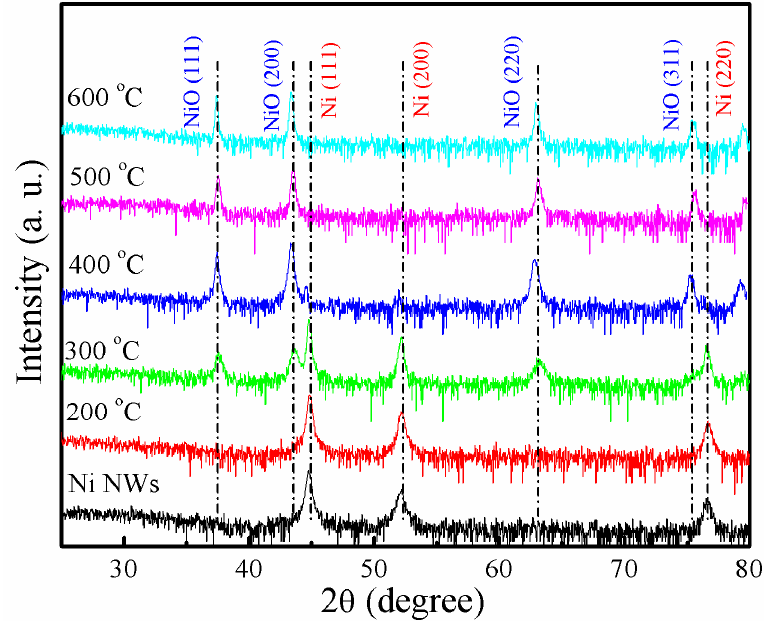
Figure 2. XRD pattern of Ni NWs as a function of oxidation temperature.